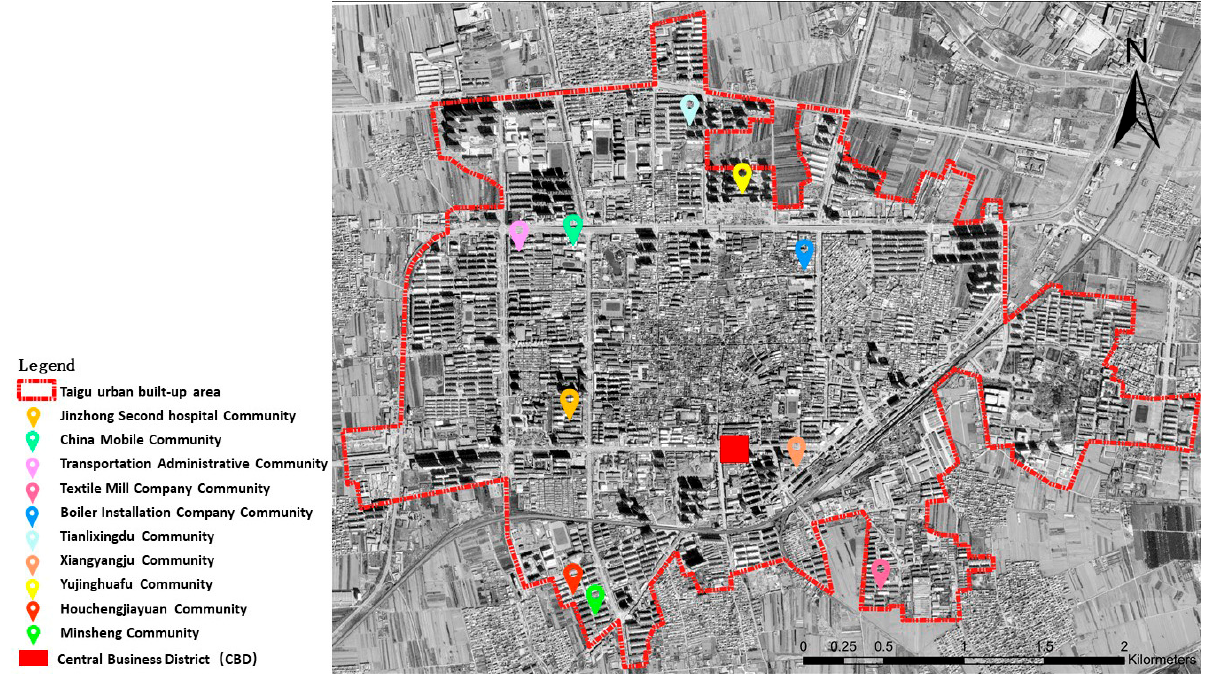
Figure 5. Locations of the ten gated communities in the Taigu urban built-up area.